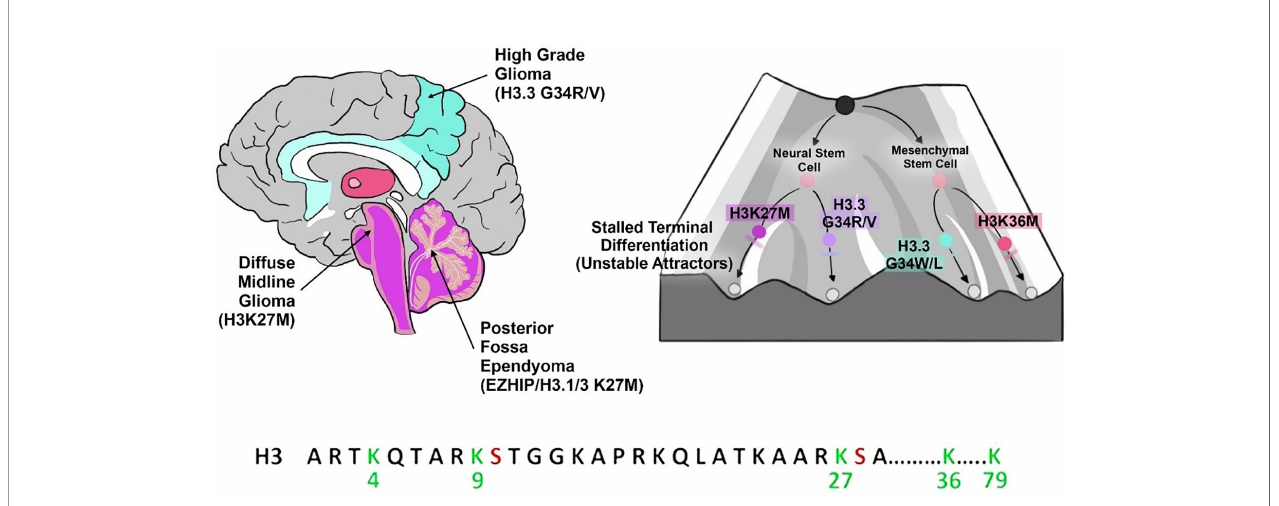
FIGURE 3 | Differentiation dynamics in pediatric glioma systems. On the left, a schematic of the discussed epigenetic variants of pediatric high-grade gliomas (pHGGs) are shown with their corresponding brain regions recapitulating altered neurodevelopmental differentiation circuits. The corresponding Waddington landscape for their stalled differentiation dynamics is shown to the right. The cancer cell fates are shown as stalled attractors on the landscape (gene expression or signalling state-space) resembling stem cell states. Below, a string of the amino acid sequence of the histone tail H3 code is provided with the sites of the recurrent epigenetic mutations in these pHGGs. Some of these epigenetic modi fi cations correspond to active chromatin marks with transcriptional activity while others are repressive marks (inhibited gene expression). The polycomb system is an essential regulator of pHGG differentiation dynamics. The toy-model system provides the biological insights underlying the complex dynamics and mathematical concepts discussed in the